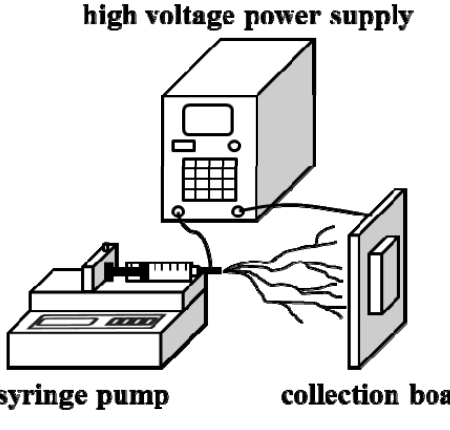
Figure 10. Electrispining device diagram.